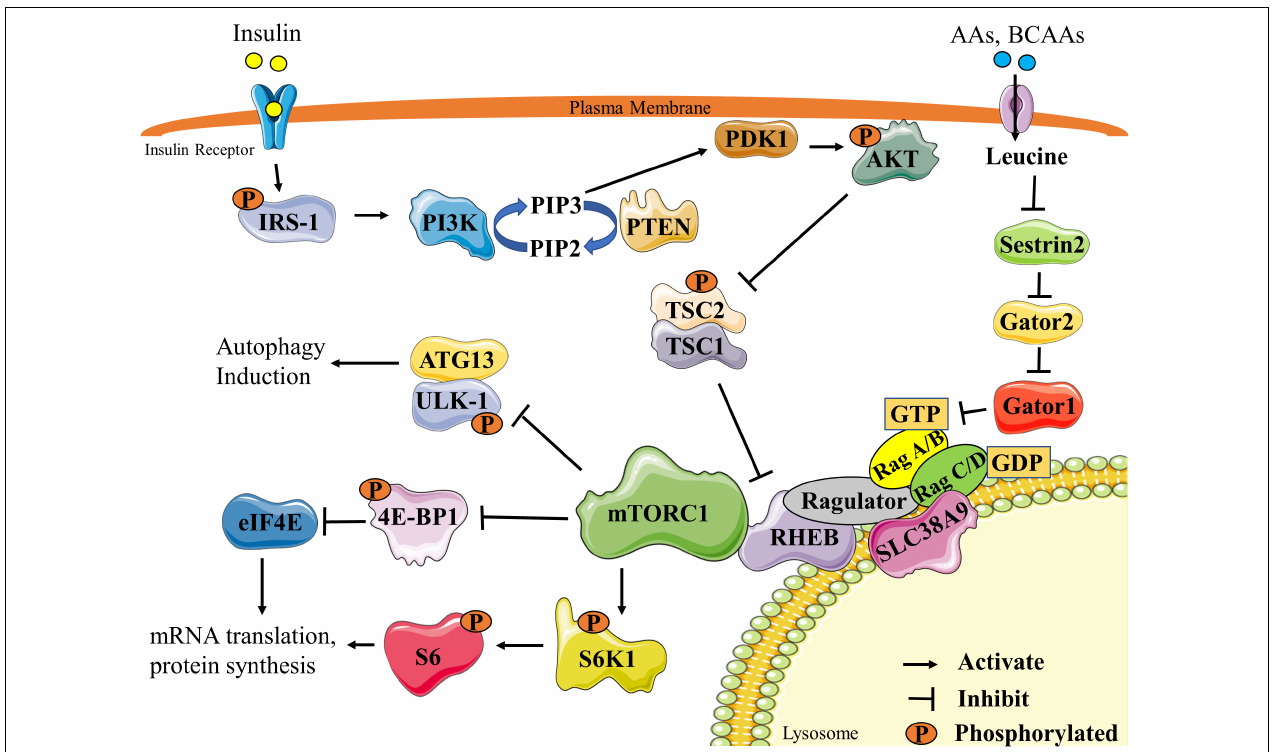
FIGURE 1 | Schematic representation of mTORC1 signaling pathway. Stimulation by insulin ultimately leads to the activation of the PI3K pathway and PIP3 synthesis. PIP3 activates PDK1, which can then phosphorylate AKT. Activated AKT phosphorylates and inactivates the TSC2/1 complex, allowing RHEB to remain GTP loaded to activate mTORC1. Activated mTORC1 activates translation machinery and protein synthesis by phosphorylating two main downstream targets, S6K1 and 4E-BP1. mTORC1 also inhibits autophagy by phosphorylating the ULK1/ATG13 complex. mTORC1 can also be activated through AA or BCAA stimulation of the sestrins/gator/RAG/ragulator pathway. Leucine, the most commonly studied BCAA, inhibits sestrin-2 leading to eventual GTP loading and RHEB activation of mTORC1. Re-drawn and modified from Fan et al. (2017) and Wolfson and Sabatini (2017). 4E-BP1, eukaryotic mRNA translation initiation factor 4E-binding protein 1; AA, amino acids; ATG13, autophagy-related protein 13; BCAA, branched-chain amino acids; eIF4E, eukaryotic mRNA translation initiation factor 4E; IRS1, insulin receptor substrate 1; mTORC1, mammalian/mechanistic target of rapamycin complex1; PDK1, 3-phosphoinositide-dependent protein kinase-1; PI3K, phosphatidylinositol-3 kinase; PIP2, phosphatidylinositol (4,5)-bisphosphate; PIP3, phosphatidylinositol (3,4,5)-trisphosphate; PTEN, phosphatase and tensin homolog; RHEB, Ras homolog enriched in brain; S6K1, ribosomal protein S6 kinase; S6, ribosomal protein S6; SLC38A9, solute carrier family 38 member 9; TSC1/2, Tuberous sclerosis proteins 1 and 2; ULK-1 unc-51 like autophagy activating